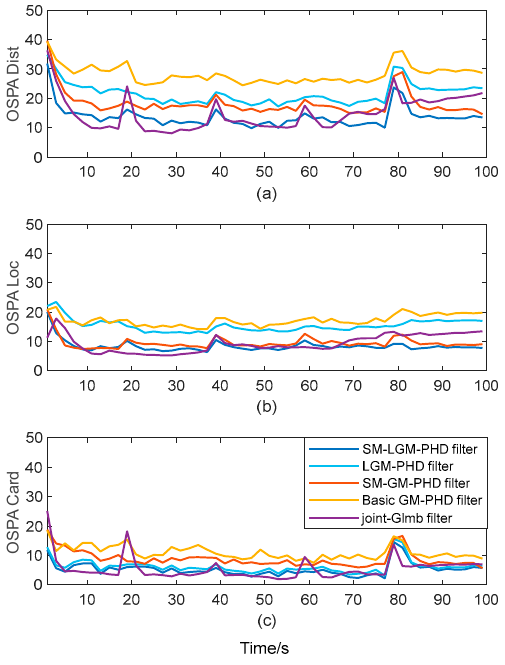
Figure 9. The average OSPA of different filters in example 1 (CV motion model) for 100 sample runs when 𝑇 (cid:3046) = 1 s ( 𝑇 (cid:3036) = 2 ms , 𝜆 = 104 , 𝑝 (cid:3005),(cid:3038) = 0.8 ). ( a ) Average OSPA distances of different filters. ( b ) OSPA locations of different filters. ( c ) OSPA cardinalities of different filters.